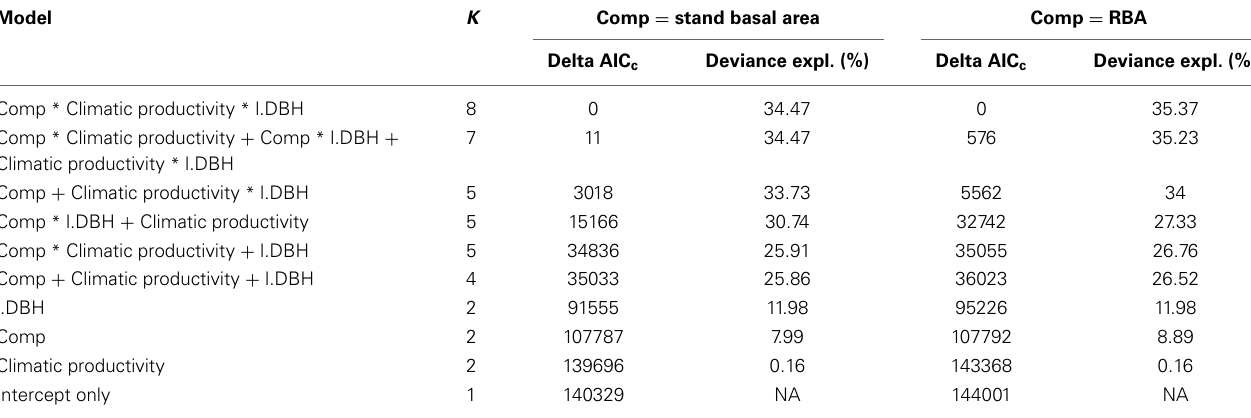
Table 3 | Comparison of linear mixed effects models describing individual tree growth.